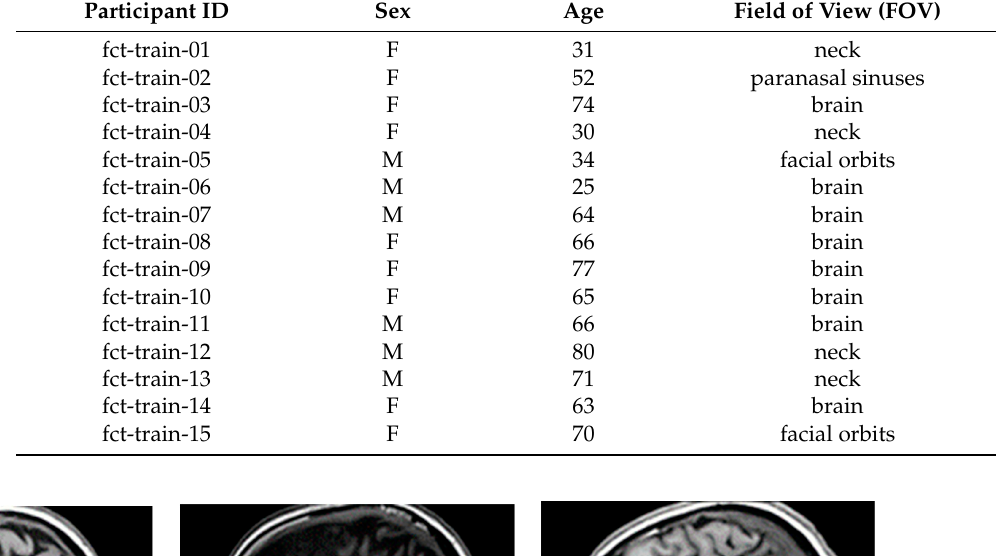
Table 1. Demographic and technical details from patients included in the training dataset.